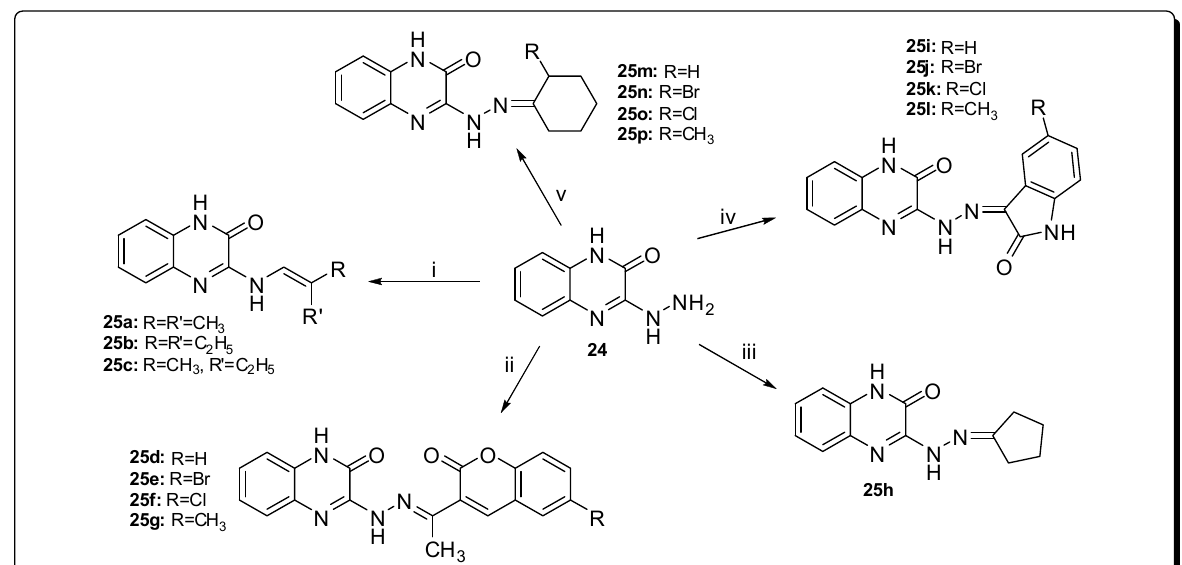
Figure 8. Synthesis of derivatives 25a – p